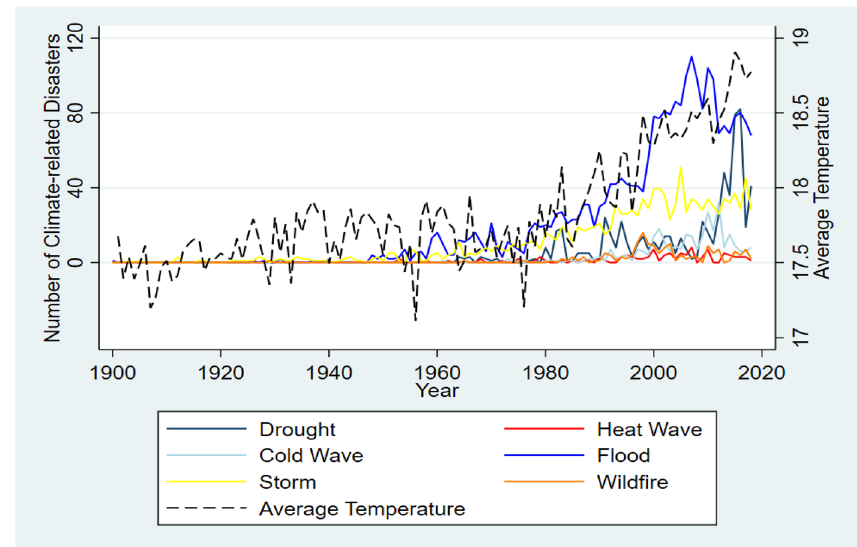
Fig. 2 Number of climate-related natural disasters and average temperature of panel countries. Source: International Disaster Database, Climatic Research